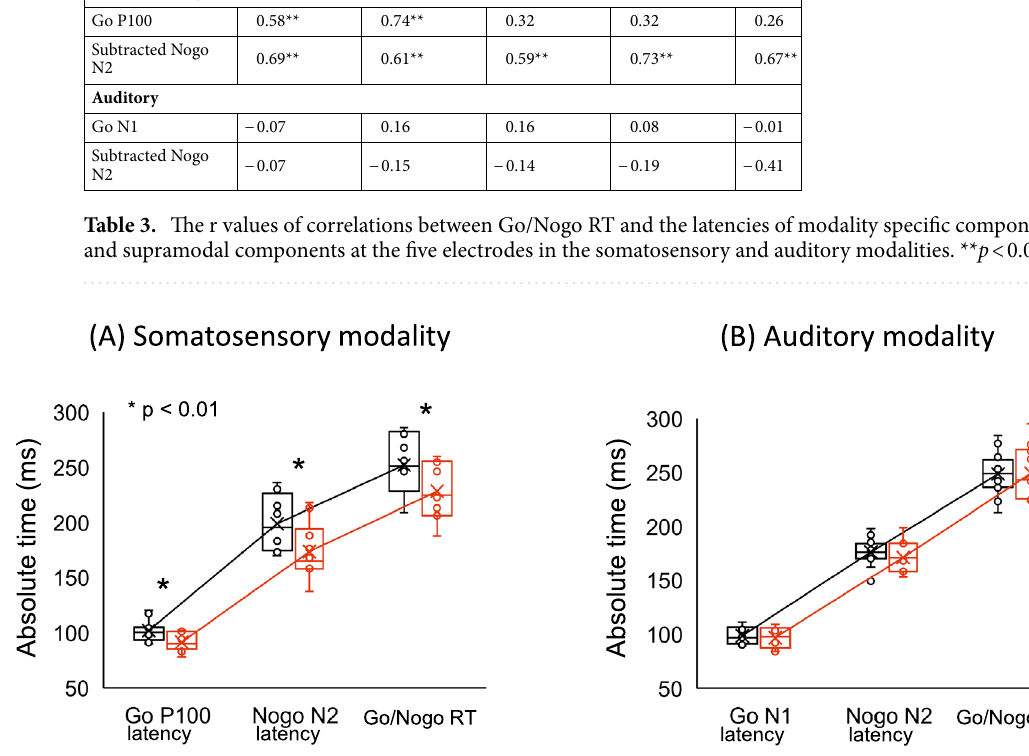
Figure 4. Comparison of neurophysiological and behavioral indices in T&F and baseball group. The box plots represent the mean (± SD) of the absolute time (ms) of neurophysiological and behavioral indices in ( A ) the somatosensory modality and ( B ) the auditory modality. The T&F and baseball groups are represented by black and red boxes, respectively. The minimum score is the lowest score, excluding outliers (shown at the end of the lower whisker). The maximum score is the highest score, excluding outliers (shown at the end of the upper whisker). The median, i.e., the midpoint of the data, is shown by the line that divides the box into two parts. The lower (Q1) and upper (Q3) quartiles are the 25% of scores that fall below the lower quartile value and 75% of the scores that fall below the upper quartile value, respectively. The interquartile range, i.e., the box, shows the middle 50% of scores. The upper and lower whiskers represent scores outside the middle 50% (i.e., the upper and lower 25% of scores). An outlier is judged by whether it falls within Q 1 − (IQR × 1.5) − Q 3 + (IQR ×